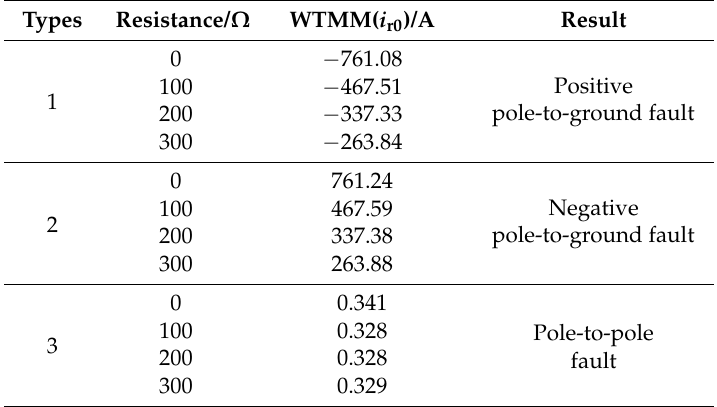
Table 4. WTMMs of 0-mode initial reverse TW current under different fault resistances.